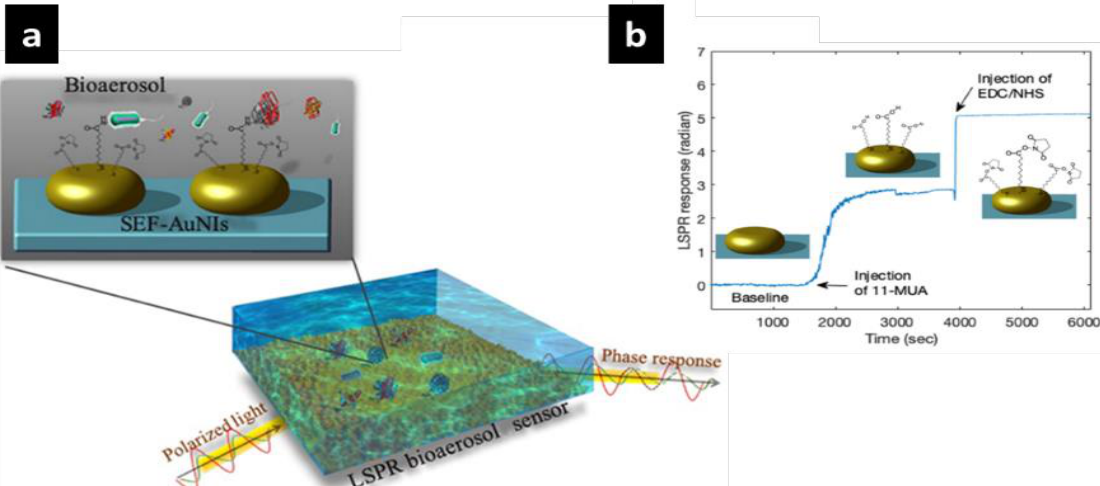
Figure 10. ( a ) Schematic illustration of AuNIs surface functionalization and bioaerosol detection. The surface of the AuINs was functionalized with succinimidyl-ester to detect bioaerosol. ( b ) In situ phase sensing response of surface functionalization, including the anchor 11-mercaptoundecanoic (11-MUA) and activator EDC / NHS. Reprinted Qiu et al. [219]. Chemical Society.